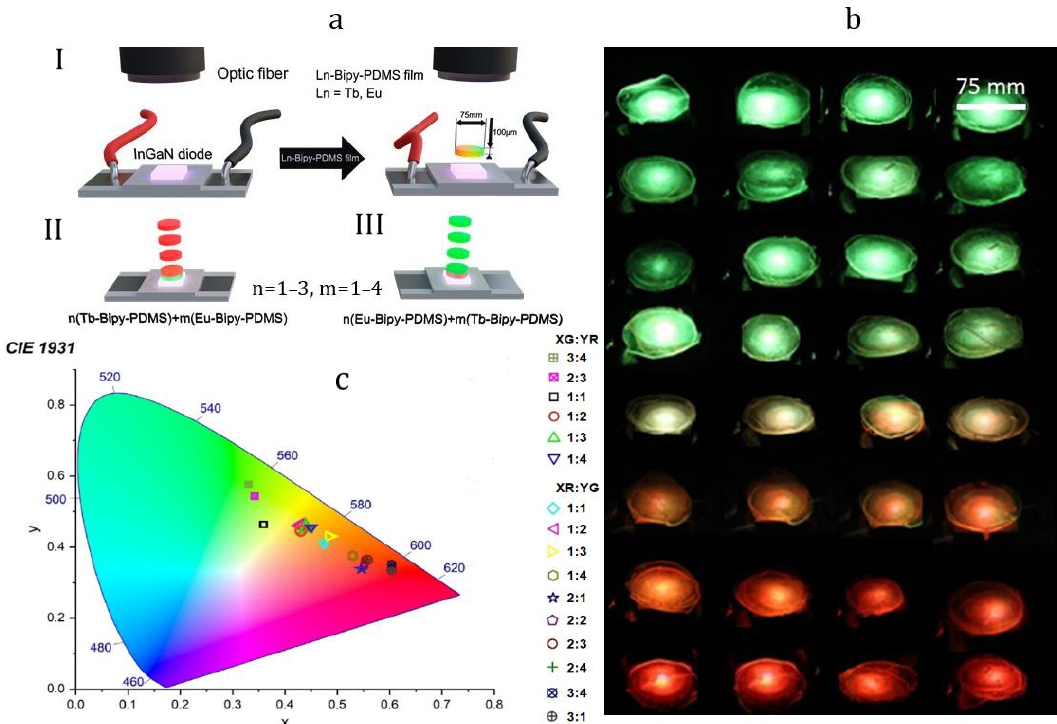
Figure 11. PL color tuning work-flow ( a ). Set-up scheme (I), first (II), and second (III) routes of the PL color tuning study. n and m reflect the numbers of red and green Ln-Bipy-PDMS films, respectively. Optical photographs stacked Tb − Bipy − PDMS and Eu − Bipy − PDMS films ( b ), and CIE 1931 color space ( c ). The notes “XG:YR”correspond to the stacks made of X green and Y red films, and “XR:YG” correspond to the stacks made of X red and Y green films. Reproduced with permission [74]. Copyright 2022, American Chemical